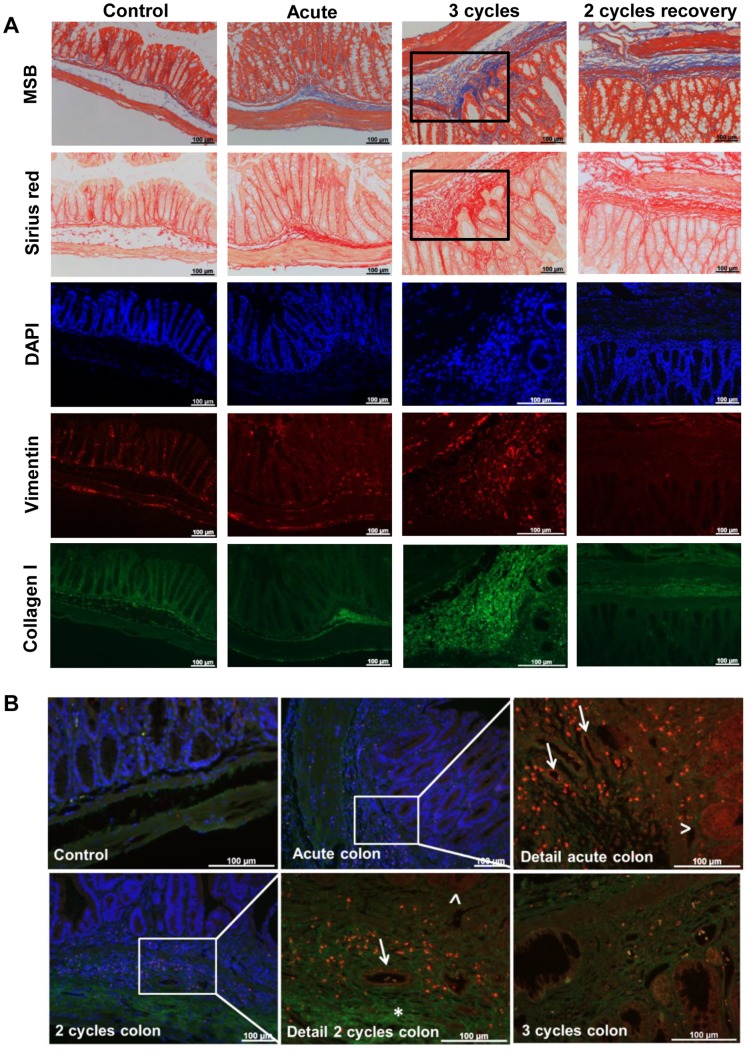
ECM changes in acute and chronic DSS colitis.(A) Representative pictures of the collagen I staining of control, acute, 3-cycles and 2-cycles with recovery colon and corresponding MSB and picro-sirius red staining. The rectangle in the upper pictures is shown with higher magnification in the lower pictures. (B) Representative pictures of the collagen III and tenascin staining in control, acute, 2-cycles and 3-cycles colon (merge image, blue = DAPI, green = collagen III and red = tenascin). The rectangle in the picture of the acute and 2-cycles colon is shown with higher magnification in the next picture (merge of collagen III and tenascin staining). No tenascin is observed in control colon. In the acute model, tenascin stains as a dot-like pattern in the mucosa and submucosa, indicating the tenascin-producing cells. Also a linear deposition of tenascin is seen around some crypts (>) and in blood vessels present in the submucosa (→). In the 2-cycles colon, the same expression of tenascin is observed. More collagen III is present in the submucosa (*). In the 3-cycles colon, less tenascin-positive cells are observed.